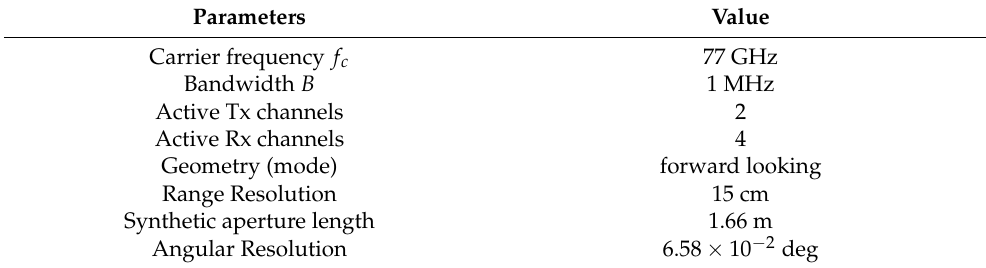
Table 1. Data Parameters